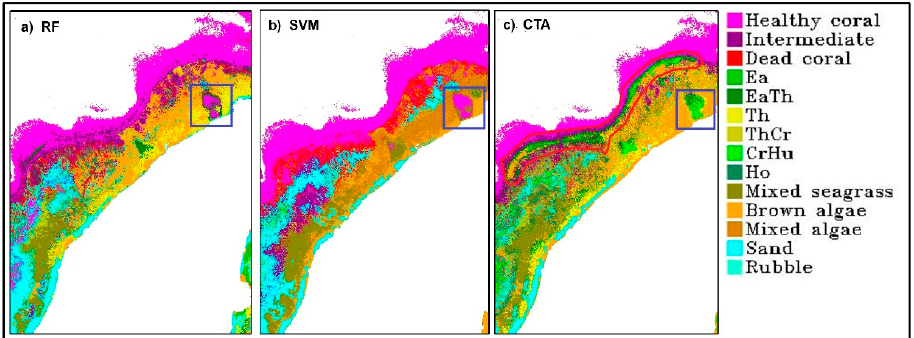
Figure 4. Comparison of misclassification between RF (OA 88.54%), CTA (OA 77.80%), and SVM (OA 75.98%). Blue boxes show the area where seagrass was misclassified as coral reef except in CTA result. However, many pixels in the reef-crest area were misclassified as seagrass classes in CTA result, where they should have been classified as coral reef class as in RF and SVM results (see red